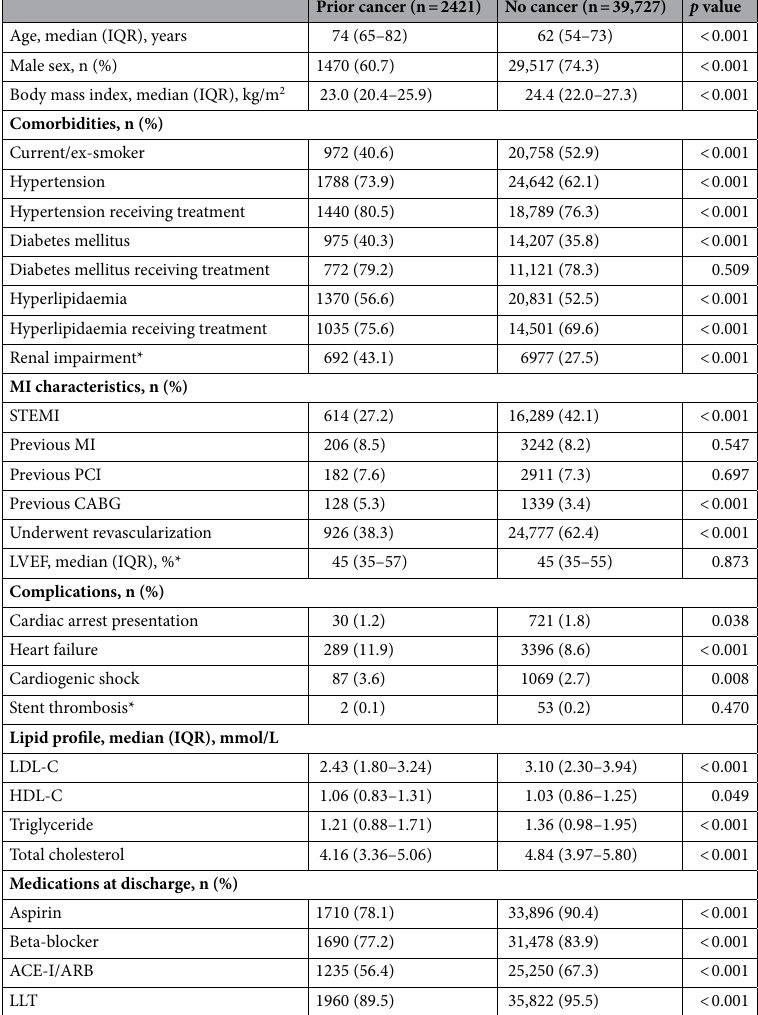
Table 1. Demographic and clinical characteristics of patients at incident myocardial infarction. ACE-I angiotensin-converting enzyme inhibitor, ARB angiotensin II receptor blocker, CABG coronary artery bypass grafting, HDL-C high density lipoprotein cholesterol, IQR interquartile range, LDL-C low density lipoprotein cholesterol, LLT lipid lowering therapy, LVEF left ventricular ejection fraction, MI myocardial infarction, PCI percutaneous coronary intervention, STEMI ST-segment elevation myocardial infarction. Unknown values were excluded from the calculation of percentages. *Data on renal impairment and stent thrombosis were available from 2012 onwards and data for LVEF were available from 2008